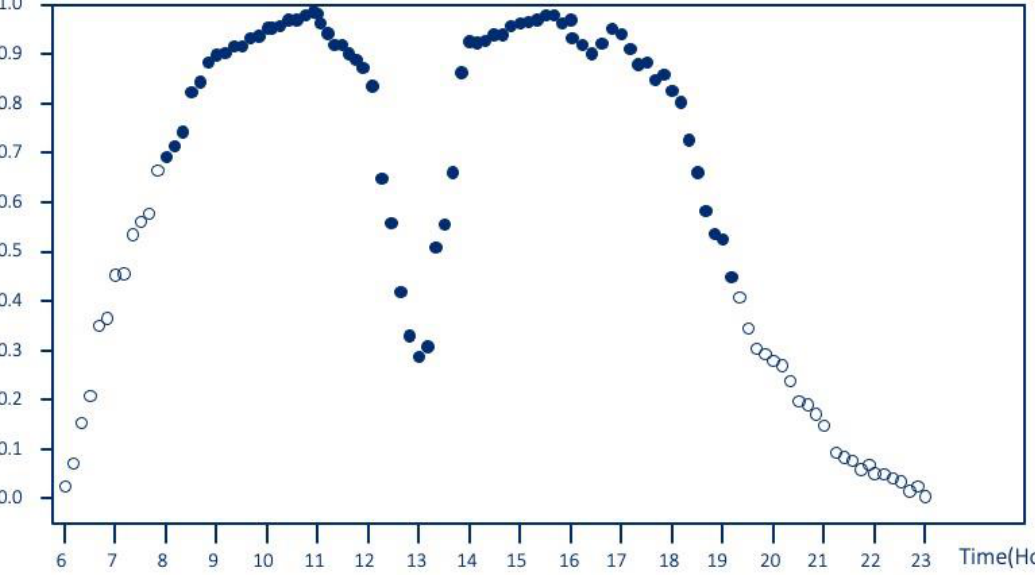
Figure 7. The scatterplot illustrates the proposed “work efficiency” diagram for one day. The sold dots represent GPS-defined work hours, whereas the hollow dots represent the GPS-defined off-work period. In this scenario, the individual’s work hours start at 8:00 and end at 18:00. The individual’s “work efficiency” is greater than 0.90 between 9:00 and 12:00, as well as between 15:00 and 17:00. The lowest “work efficiency” occurs at around 13:00; at which point, the efficiency level is similar to those during off-work